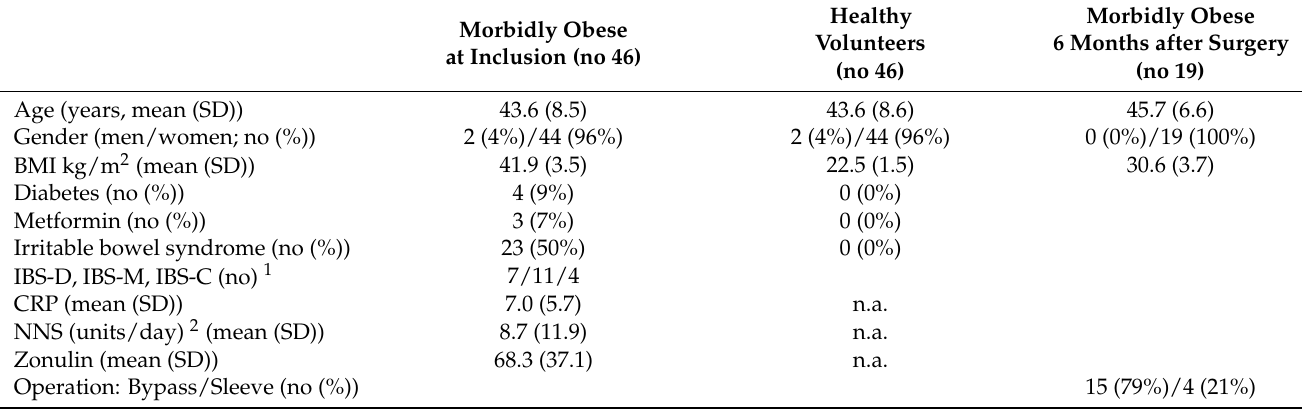
Table 1. Participant